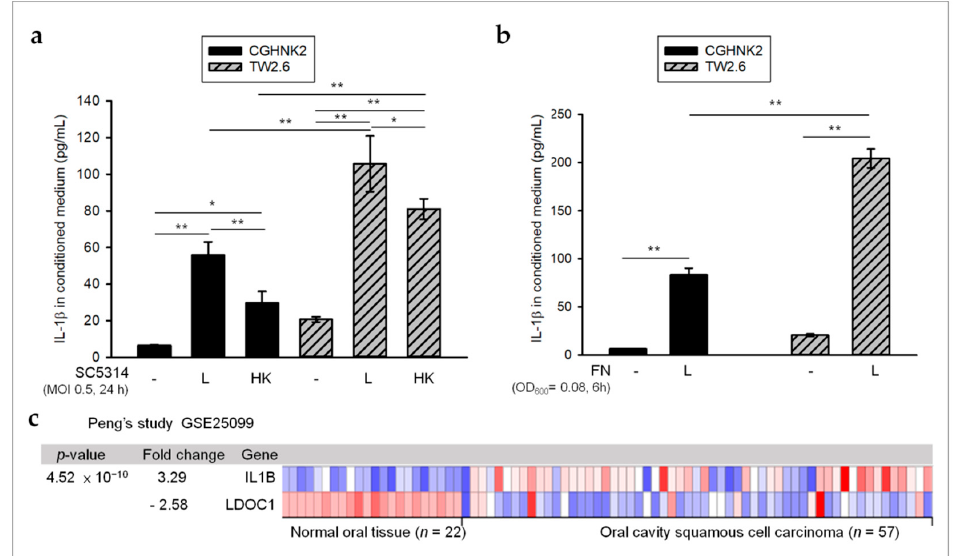
Figure 2. Inverse relationship between LDOC1 and CA SC5314- or FN -induced IL-1 β in OSCC. ( a , b ) LDOC1 -deficient TW2.6 cells secrete more microbe-induced IL-1 β as compared with LDOC1 -expressing CGHNK2 cells. Cytometric bead array (CBA) analysis of IL-1 β in conditioned medium of CGHNK2 and TW2.6 cell lines without microbes or with either live (L) or heat-killed (HK) CA SC5314 (MOI 0.5) ( a ) and L FN (OD 600 = 0.08) ( b ) for 24 and 6 h, respectively. Results are presented as concentrations (pg/mL). Data are representative of at least three independent experiments (mean + S.D.), analyzed using the ANOVA test. * p < 0.05 and ** p < 0.01. ( c ) The mRNA expression profiles of LDOC1 and IL-1B in OSCC tumors ( n = 57) and normal oral tissues ( n = 22) were obtained from publicly